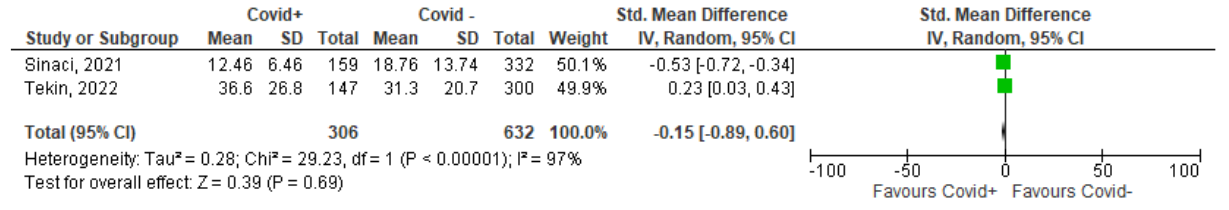
Figure 5. COVID-19-positive pregnant women vs. COVID-19-negative pregnant women—vitamin D serum levels [32,33].